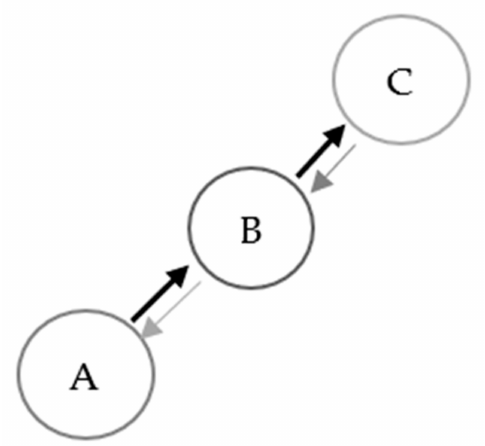
Figure 1. Physical beings A, B, and C affect each other, with qualitatively and quantitatively variable effects. Being A strongly affects and causes some change in B; the changed B affects respectively C. The oppositely directed effects are thought to be weak and can be ignored, as with all other possible effects between these and surrounding